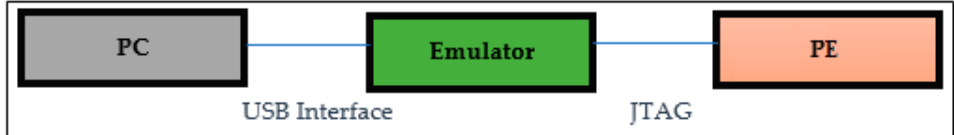
Figure 4. Steps for detection and localization of the errors.